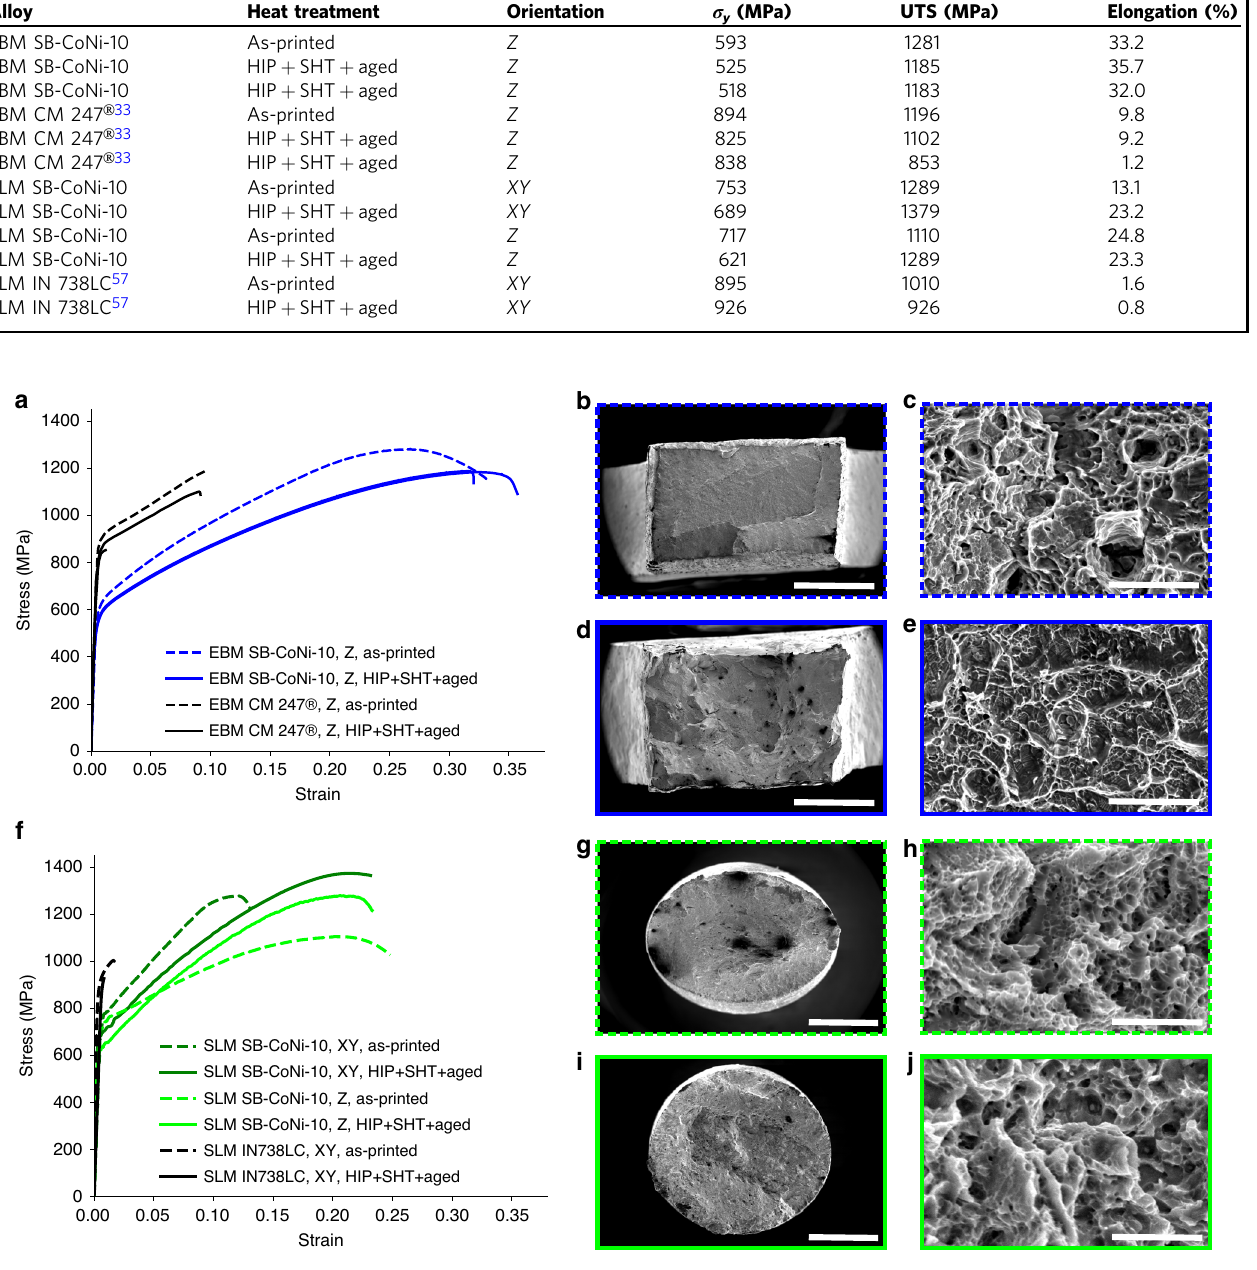
Fig. 6 Tensile testing of EBM and SLM SB-CoNi-10 at room temperature. Stress – strain curves for quasi-static tensile tests at room temperature on the a EBM and f SLM materials in the as-printed and HIP + SHT + aged conditions compared to EBM CM 247 33 and SLM IN738LC 57 . SEM fractography of the b – e EBM samples and the g – j SLM samples in the b , c , g , h as-printed and d , e , i , j HIP + SHT + aged conditions reveal features indicative of ductile fracture in all specimens. The higher magni fi cation images are taken near the center of each fracture surface. The scale bars for b , d are 1 mm. The scale bars for g , i are 2 mm. The scale bars for c , e , h , j are 5 μ